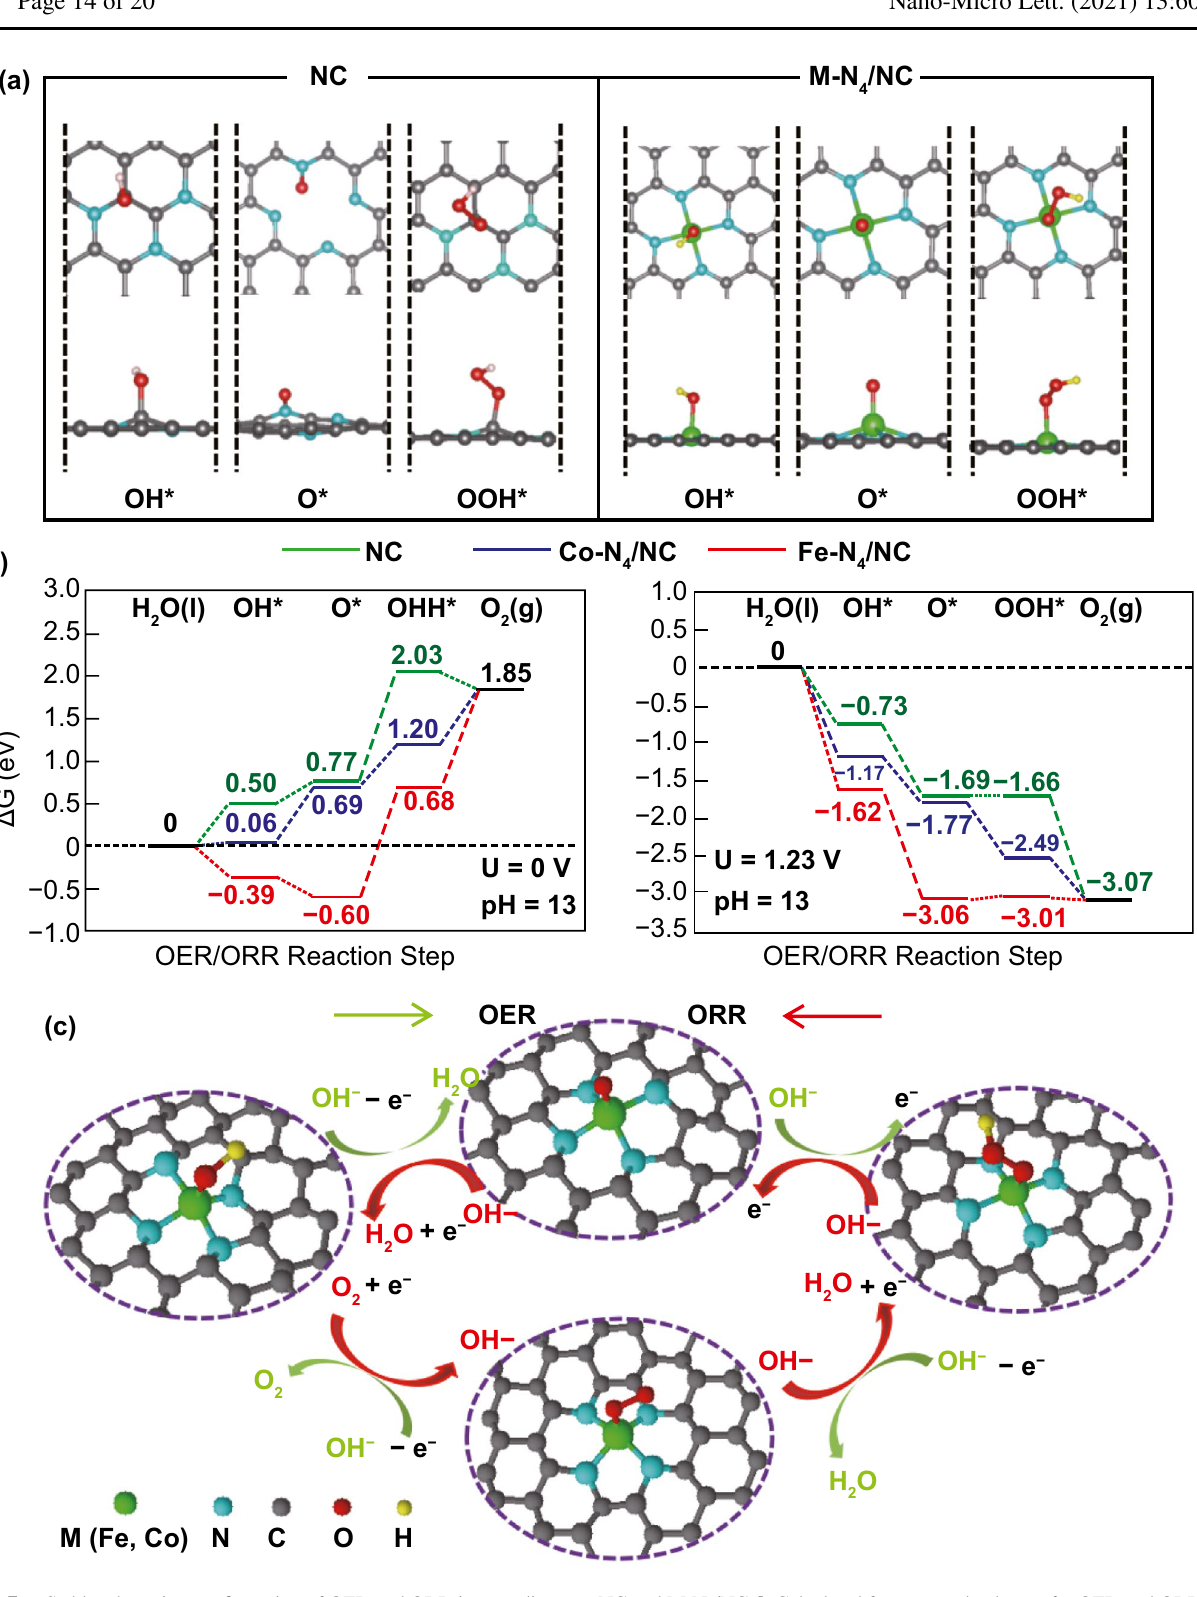
Fig. 7 a Stable adsorption configuration of OER and ORR intermediates on NC and M-N 4 /NC. b Calculated free energy landscape for OER and ORR on NC (green), Co-N 4 (blue) and Fe-N 4 (red)—embedded graphene at U = 0 V (left) and 1.23 V (right). c Structure of OH*, O*, OOH* adsorbed M-N 4 and the mechanisms in OER/ORR processes. The gray, blue, green, red, and yellow sphere are C, N, M (Fe, Co), O, and H